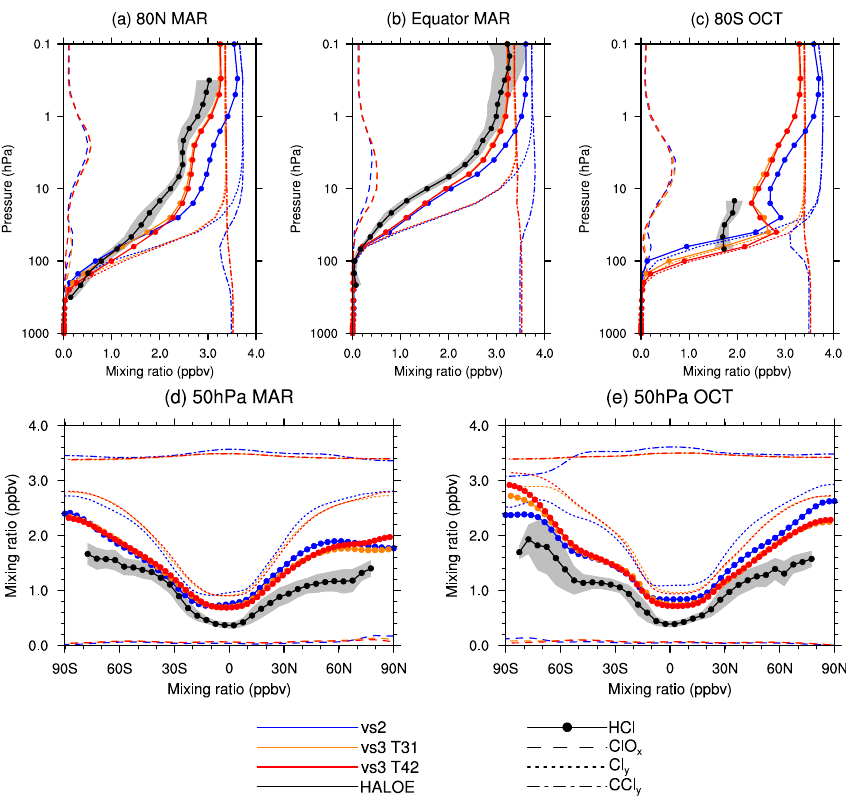
Fig. 9. Same as in Fig. 6 but for various chlorine species in ppbv. Dashed lines: odd chlorine (ClO x ); dotted lines: total inorganic chlorine (Cl y ); dash-dotted lines: total inorganic plus organic chlorine (CCl y ); filled circles: